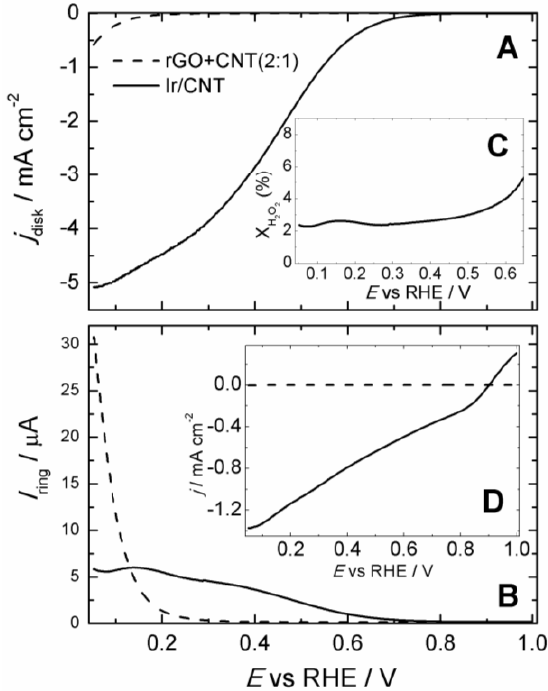
Figure 7 . Normalized ( A ) rotating disk and ( B ) ring voltammograms recorded during oxygen reduction at the Ir/CNT and rGO+CNT(2:1) films in oxygen-saturated 0.5-mol dm − 3 H 2 SO 4 at the scan rate of 10 mV s − 1 and rotation rate of 1600 rpm; ( C ) formation of H 2 O 2 intermediate generated during oxygen reduction at Ir/CNT under conditions of RRDE voltammetric experiment; ( D ) normalized rotating disk voltammograms recorded at the Ir/CNT and rGO+CNT(2:1) films in nitrogen-saturated 0.5-mol dm − 3 H 2 SO 4 in the presence of 1-mmol dm − 3 H 2 O 2 . Scan rate: 10 mV s − 1 ; rotation rate: 1600 rpm.